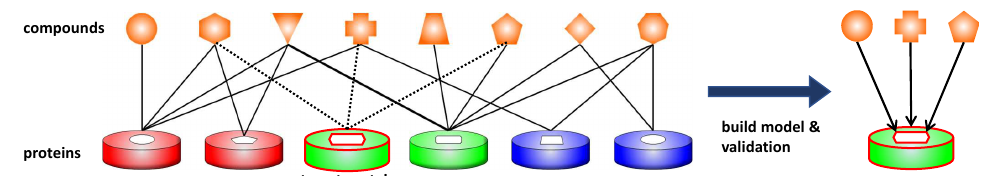
Figure 2. Schematic diagram of the creation of a virtual orphan GPCR model. The solid and dotted lines between the compounds and proteins indicate known activities confirmed from the ChEMBL database. The same solid and dotted lines indicate the Compound–Protein combinations that are used as input to machine learning and the Compound–Protein combinations that are not used as input to machine learning, respectively. Proteins connected by dotted lines indicate a virtual orphan target. The prediction accuracy is verified by screening known GPCR associated